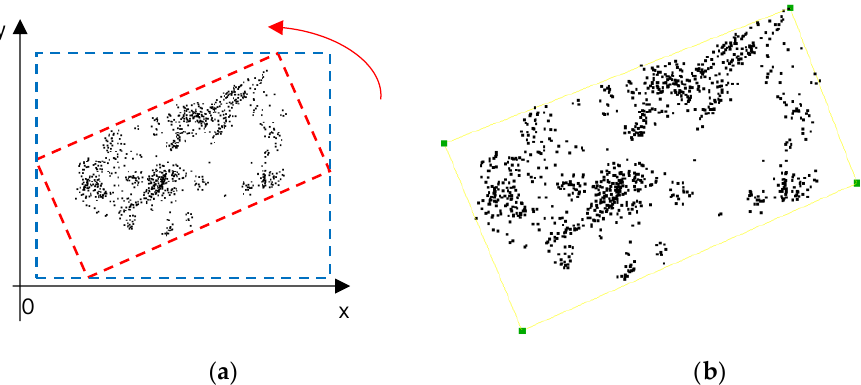
Figure 6. Calculation of circumscribed rectangle: ( a ) schematic diagram of the plane projection; ( b ) corners of the circumscribed rectangle.